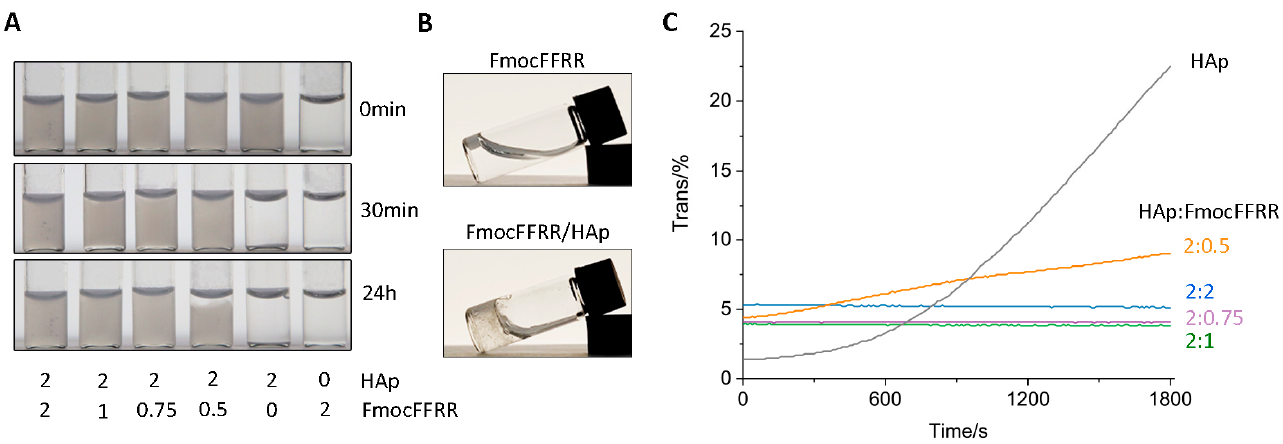
Figure 2. ( A ) Optical images of 2 mg/mL HAp particles dispersed in FmocFFRR solution in ddH 2 O at different concentrations (0, 0.5, 0.75, 1.0, 2.0 mg/mL) for 0 min, 30 min, or 24 h. ( B ) Optical images of 2 mg/mL FmocFFRR in the absence or presence of HAp particles (4 mg/mL) in ddH 2 O. ( C ) Transmittance curves of 2 mg/mL HAp dispersed in ddH 2 O or in FmocFFRR assemblies at 0.5, 0.75, 1.0, or 2.0 mg/mL over a 30 min period. Transmittance was measured at 600 nm.